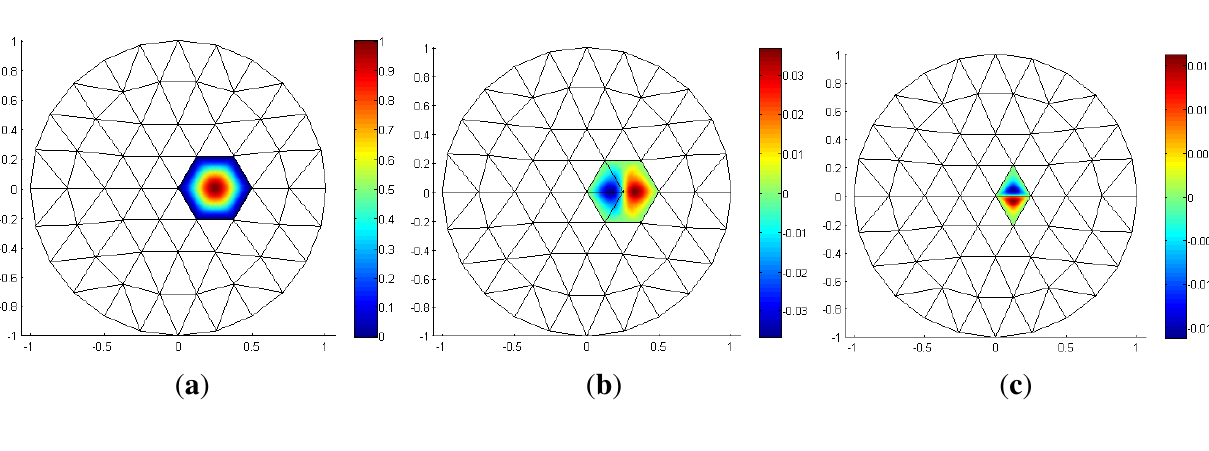
: mid-edge normal 3 N + k